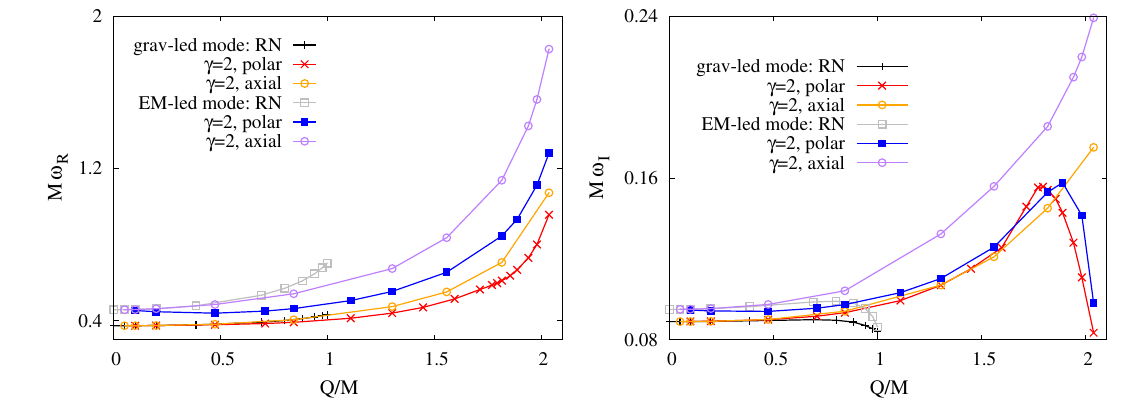
Fig. 8 Illustration of broken isospectrality in the presence of a dilaton for l = 2 modes